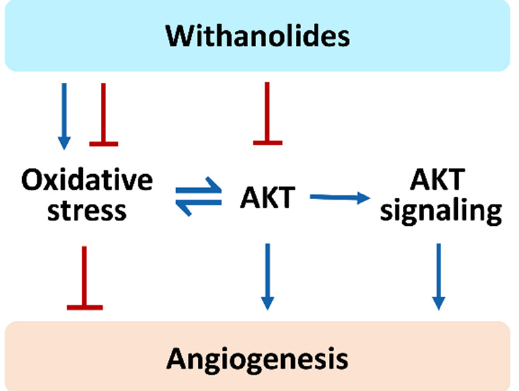
Figure 4. Hypothesis: Withanolides affecting oxidative stress and AKT signaling may modulate angiogenesis, although this is rarely reported. Detailed investigation is warranted to examine the potential angiogenesis-modulating effects of withanolides in the future.